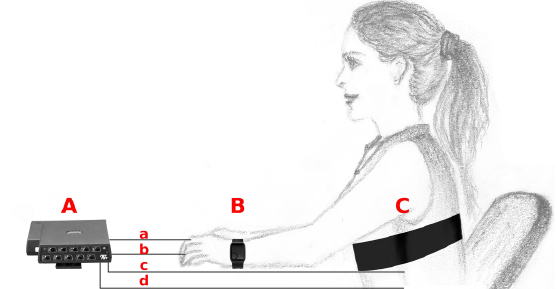
Figure 1. Illustration showing the devices used for the acquisition of physiological signals. A : Thought Technology FlexComp (picture from www.thoughttechnology.com) with four wired sensors: ( a ) electrodermal activity, ( b ) blood volume pulse, ( c ) electrocardiogram, ( d ) respiration; B : Empatica E4 (picture from www.empatica.com); C : ComfTech